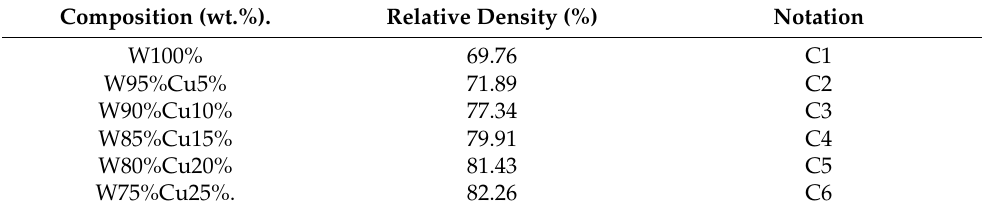
Table 1. Composition of the samples, relative density, and their respective notations. Composition (wt.%).